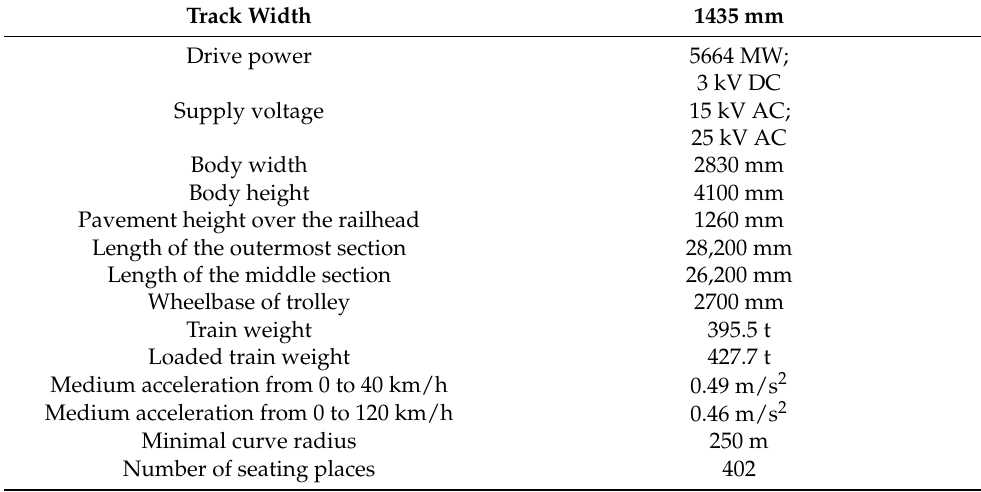
Table 1. Basic technical parameters of the ETR610 vehicle—ED250 series—Pendolino [20–22].